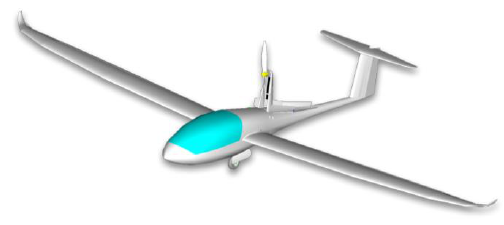
Fig. 4. Taurus Electro motor-glider model [9]